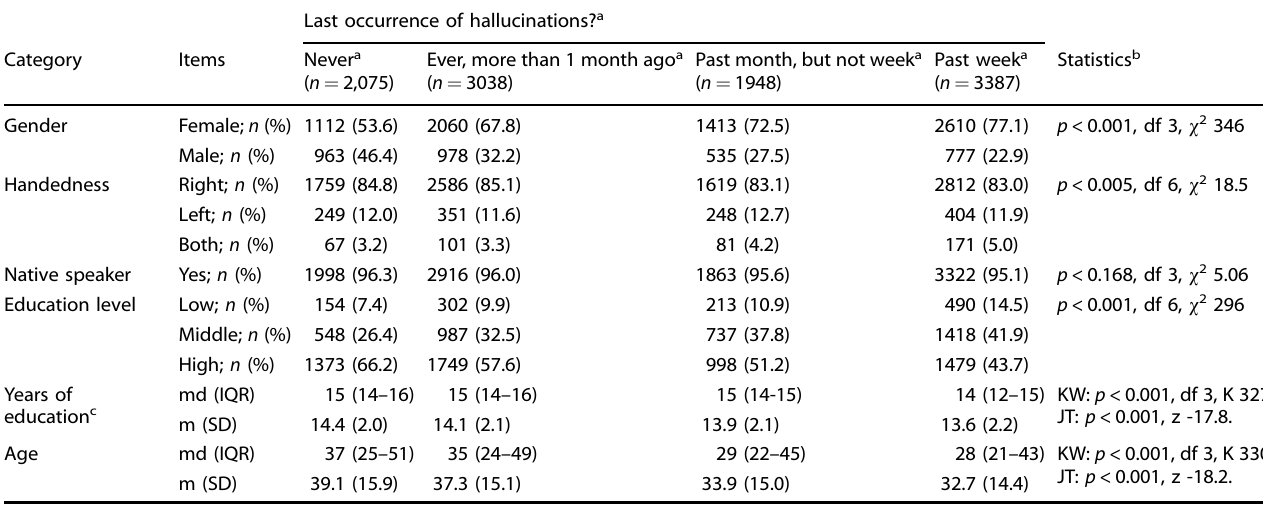
Table 2. Demographic characteristics after categorization and comparison of participants based on the most recent presence of hallucinations. Last occurrence of hallucinations? a